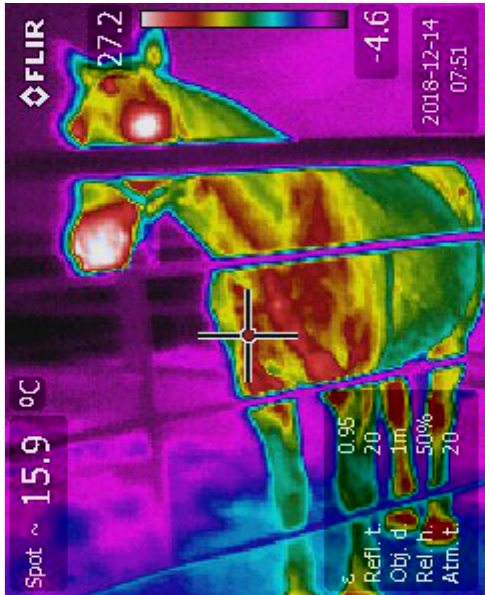
Figure 2. FLIR® IR image with temperature spot on "point of